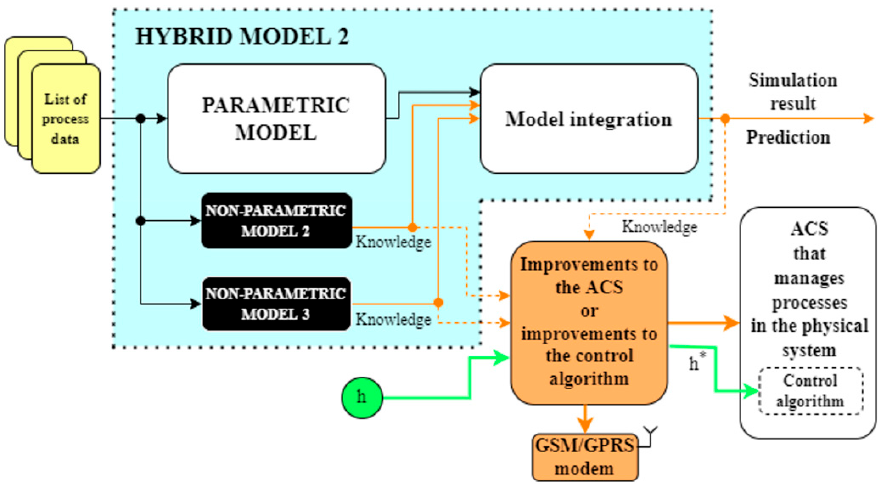
Figure 29. The extended hybrid model of the serial-parallel structure.